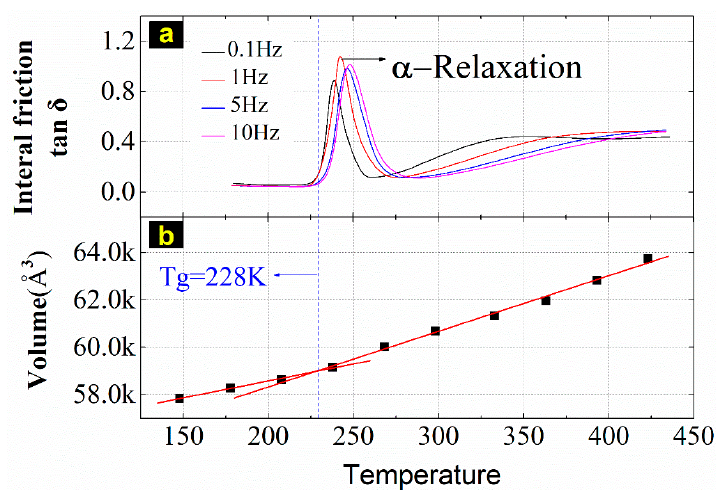
Figure 5. The glass transition temperature of EPDM: ( a ) shows the relaxation curve of 0.1, 1, 5, and 10 Hz at temperatures ranging from 183 to 438 K. δ is the phase angle. The simulation results in ( b ) are the average of three independent NPT simulations for 20 ps under the compass field. The volumes at temperatures of 148, 178, 208, 238, 268, 298, 333, 363, 393 and 423 K are 57,853.14, 58,284.27, 58,645.86, 59,164.04, 60,023.98, 60,683.87, 61,327.6, 61,969.22, 62,836.05, and 63,743.02 Å 3 , respectively.